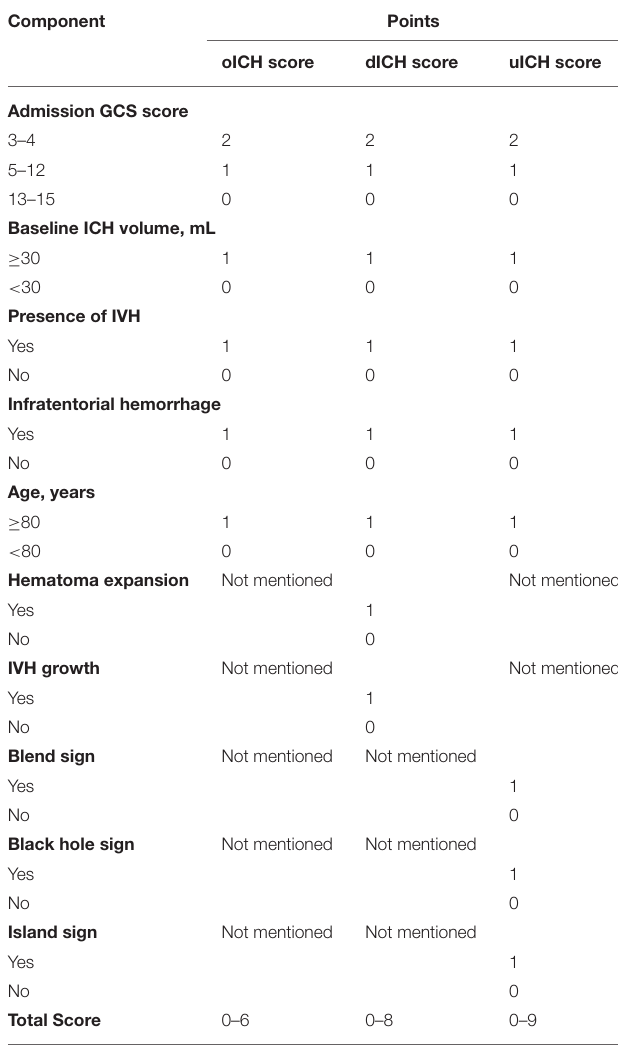
TABLE 3 | Determinants of the oICH score, dICH score, and uICH score. Component